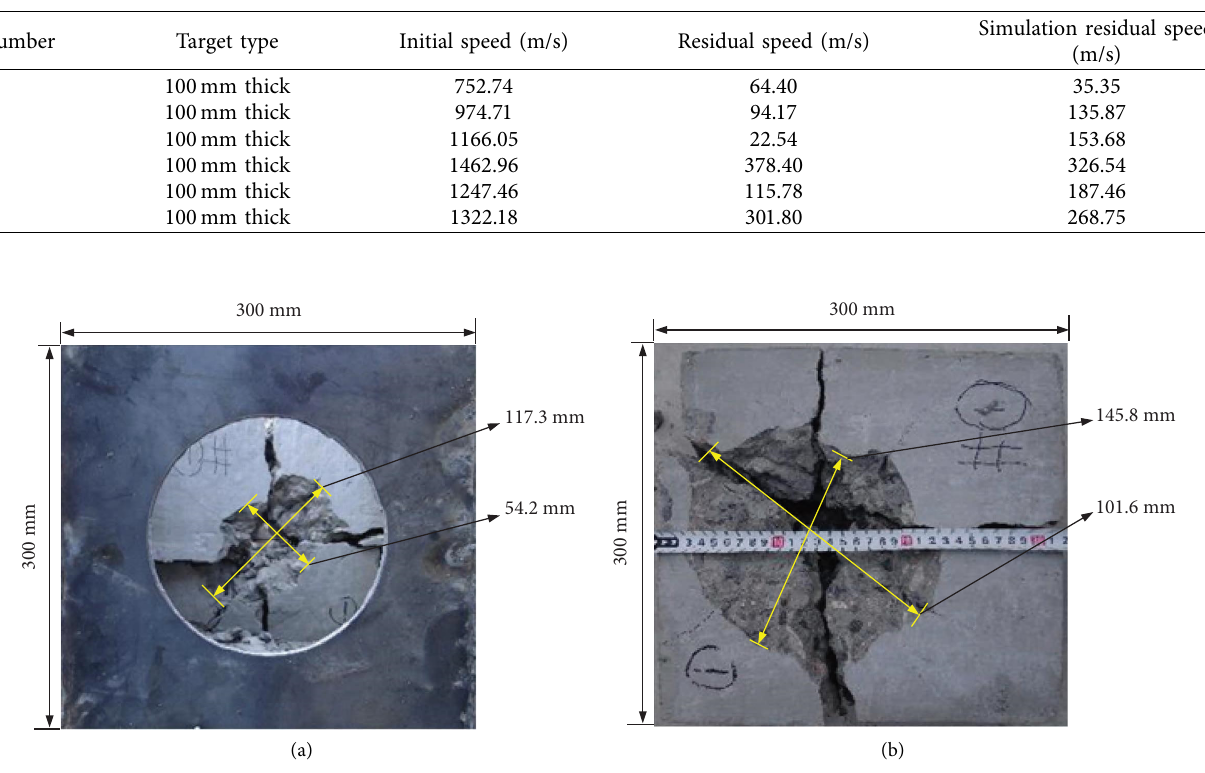
Figure 5: Front and back of target plate damage with a fragment velocity of